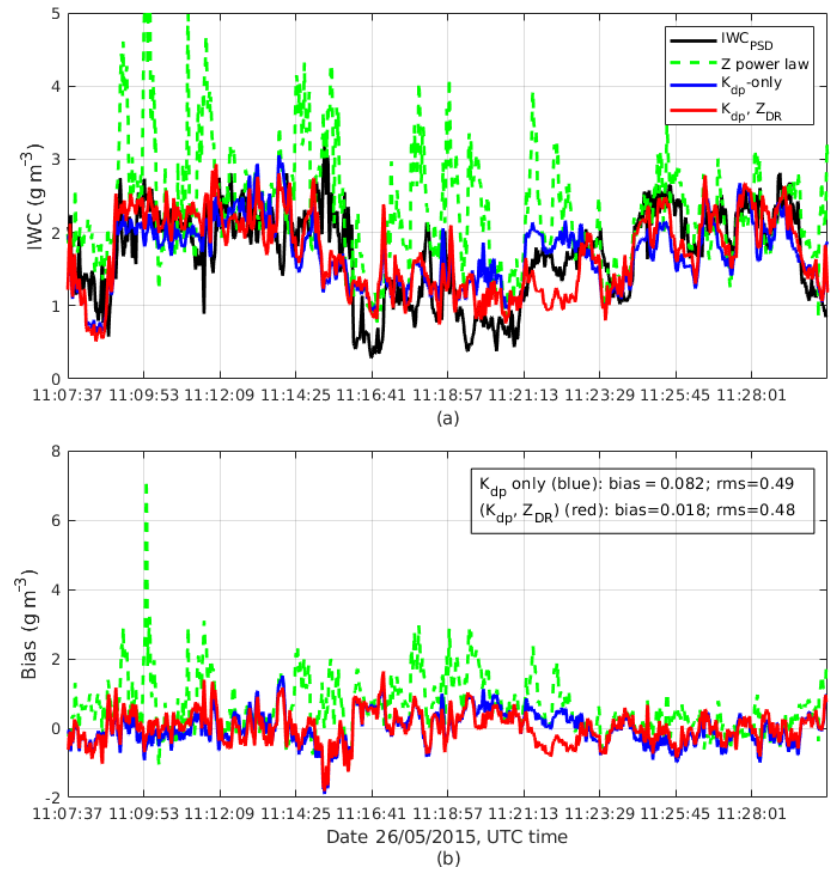
Figure 7. Panel (a) shows IWC PSD (black line), estimated IWC using reflectivity (dashed green line), K dp alone (blue line), and the ( K dp , Z DR ) combination (red line) for the 26 May case. Panel (b) shows estimation biases for the three estimators. Average biases for IWC( Z ), IWC( K dp ), and IWC( K dp , Z DR ) are 0.60, 0.082, and 0.018gm − 3 and rms differences are 0.98, 0.49, and 0.48gm − 3 for the three algorithms, respectively.